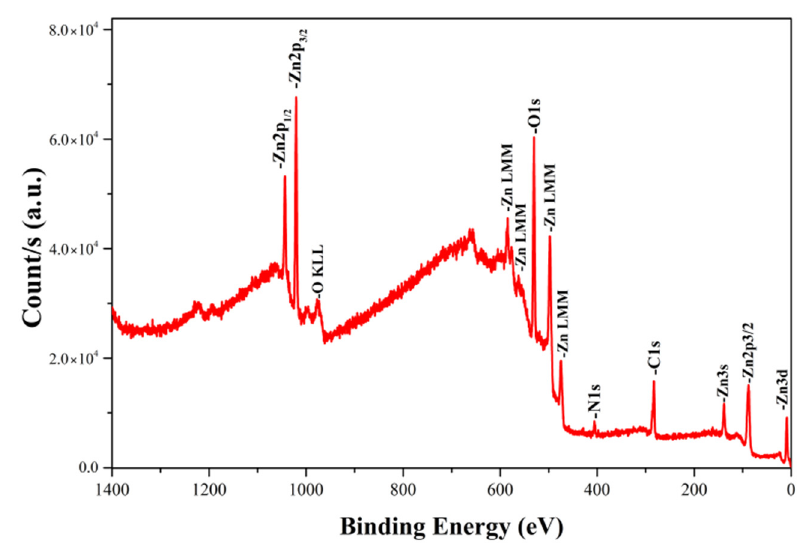
Figure 6. X-ray photoelectron spectroscopy (XPS) survey spectra of a coated wood sample ( c = 1.8 M, v = 30 mm/s, Q air = 17 L/min, 3 passes).